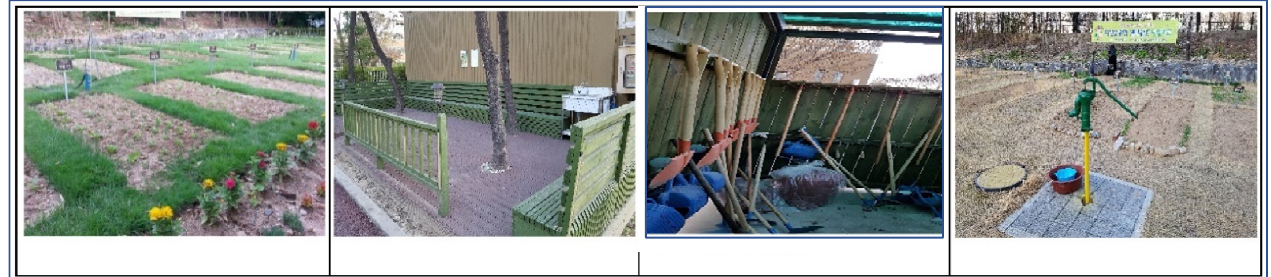
Figure 4. Site of the HEG program. HEG: group participating in the apartment community garden program with a focus on horticultural